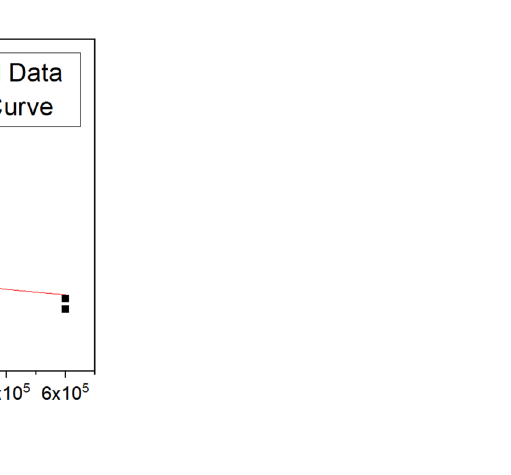
Figure 5. S–N curve of WC–Co